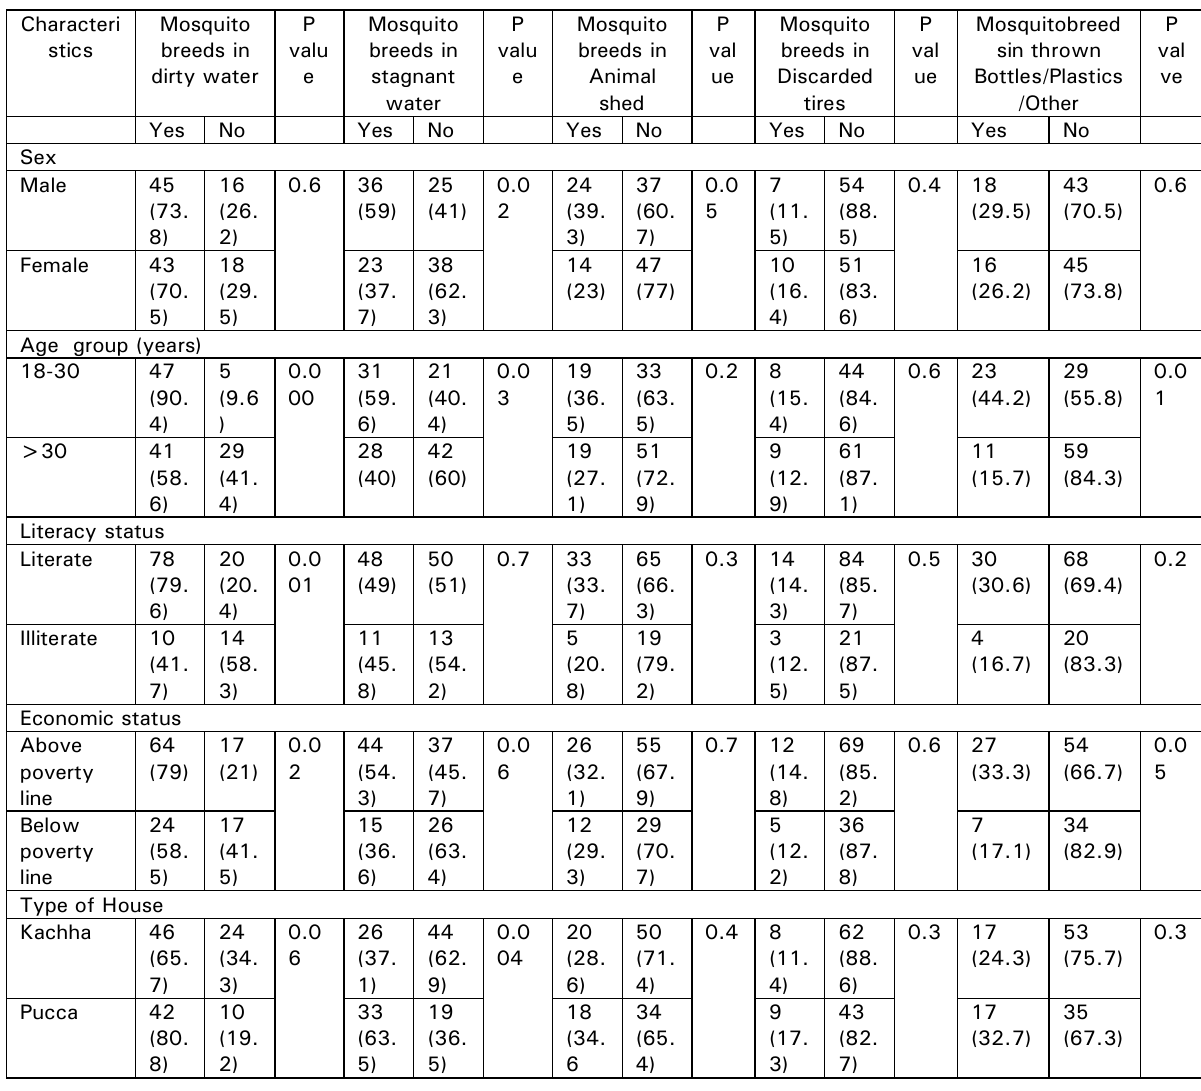
Table 3. Perception on breeding places of mosquito